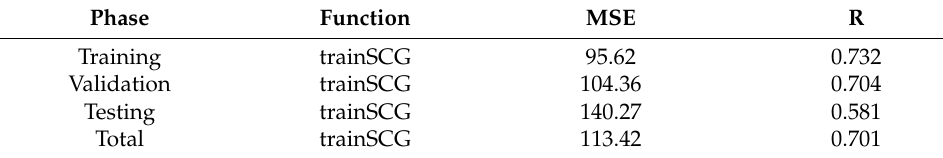
Table 6. Summary of SCGB algorithm model assessment parameters.